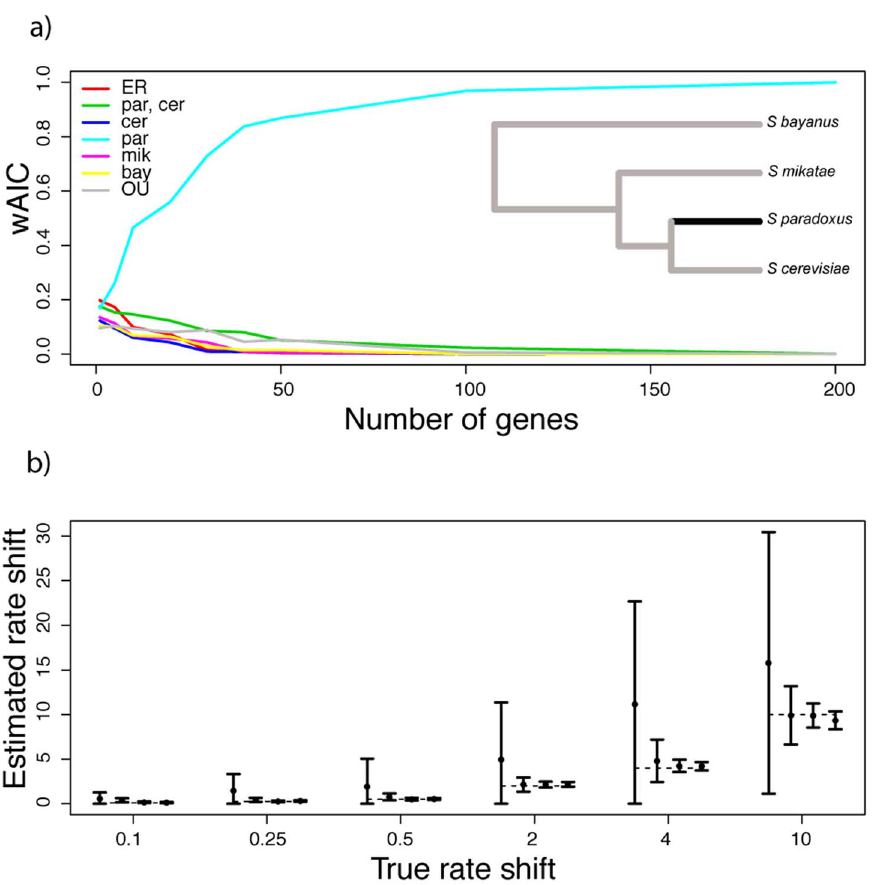
Figure 1. Phylogenetic inference of the evolutionary history of yeast pathway regulation from data simulated under a model of a lineage-specific, accelerated evolutionary rate. Each panel reports results of the inference of evolutionary history from expression of the genes of a pathway in yeast species, simulated under a model of a shift in evolutionary rate on the branch leading to S. paradoxus (dark line in inset phylogeny in (a)). (a), Each trace reports the strength of support for one evolutionary model in inferences from simulated expression in pathways of varying size. The x axis reports the number of genes in the pathway and the y axis reports the Akaike weight of the indicated model. Data were simulated under a Brownian motion model in which the rate of regulatory evolution for each gene was drawn from an inverse-gamma distribution with a ~ 3 , b ~ 2 and, for the branch leading to S. paradoxus , increased by a factor of 5 . In the legend, ER denotes an equal-rates Brownian motion model in which rates of evolution were the same on each branch of the phylogeny; OU denotes an Ornstein-Uhlenbeck model of evolution; and species name abbreviations denote Brownian motion models of accelerated evolutionary rate on the subtrees leading to the respective taxa. (b), Each set of symbols reports results from expression data simulated under a Brownian motion model in which the rate of regulatory evolution for each gene was drawn from an inverse-gamma distribution with a ~ 3 , b ~ 2 and, for the branch leading to S. paradoxus , increased by the factor indicated on the x axis. In a given set of symbols, filled circles report the mean, and vertical bars report the standard deviation of the sampling distribution, of the inferred rate shift parameter in simulations of pathways containing, from left to right, 2, 10, 50, and 100 genes. Results from simulations of expression under models of evolutionary rate shifts on other branches of the yeast phylogeny, and simulations of expression in the absence of a lineage-specific evolutionary rate shift, are reported in Supplmentary Figures 1–5.